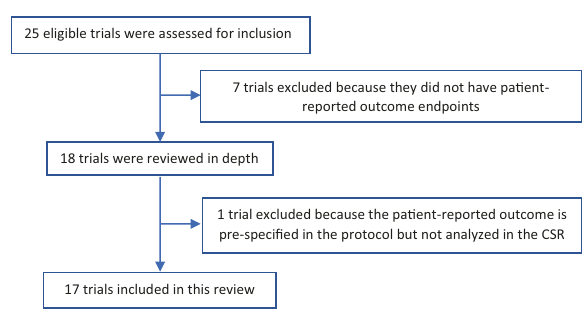
Fig. 1 Consort diagram/ fl owchart for trials analyzed in the review. CSR clinical study